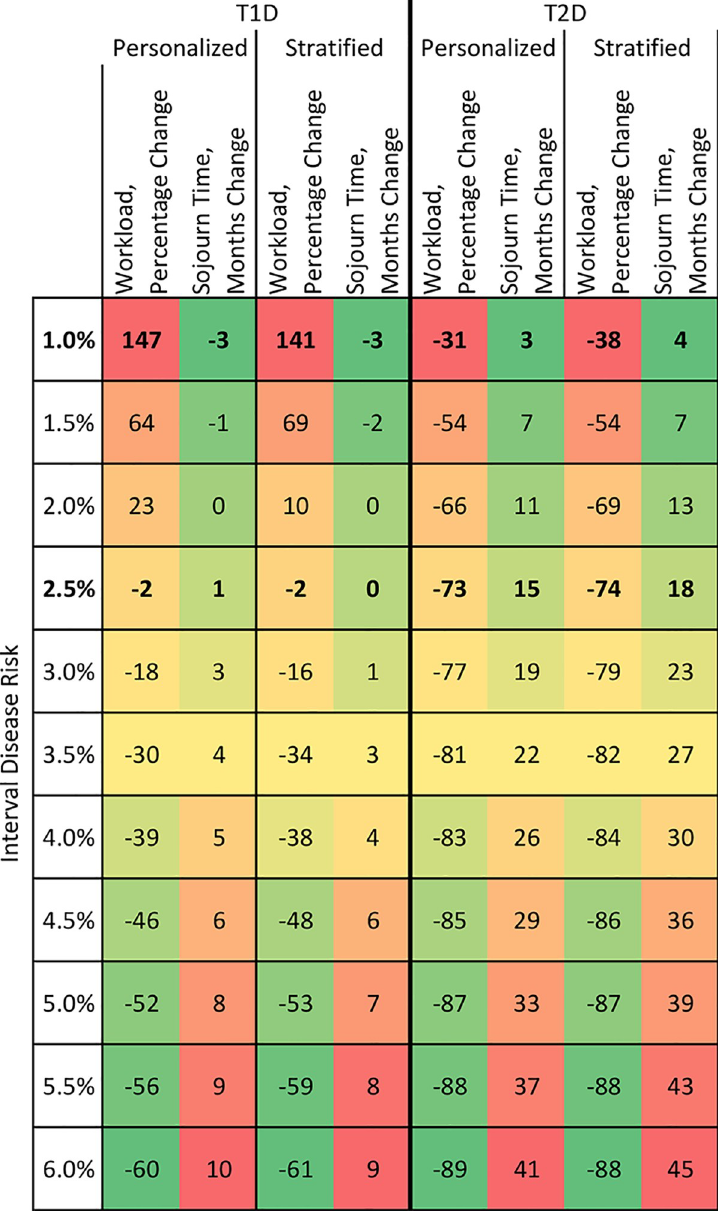
Fig 1. Comparison of screening schedules in terms of changes in number of required screenings and sojourn time relative to the currently implemented policy. Heatmap showing policy implications for a number of personalised and stratified schedules for patients with type 1 diabetes (T1D) and type 2 diabetes (T2D) in terms of changes to workload (percentage change) and sojourn time (change in months) compared to the current policy. Screening schedules are varied by accepted interval disease risks ( y -axis) and personalised or stratified setting ( x -axis). Red shades show large increases and green shades show large decreases in workload or sojourn time compared to the current screening schedule, with yellow shades showing intermediate levels of change. For example, a personalised screening schedule for patients with T1D with an accepted interval disease risk of 4.0% would reduce overall workload by 39% and sojourn time by 5 months compared to the currently implemented